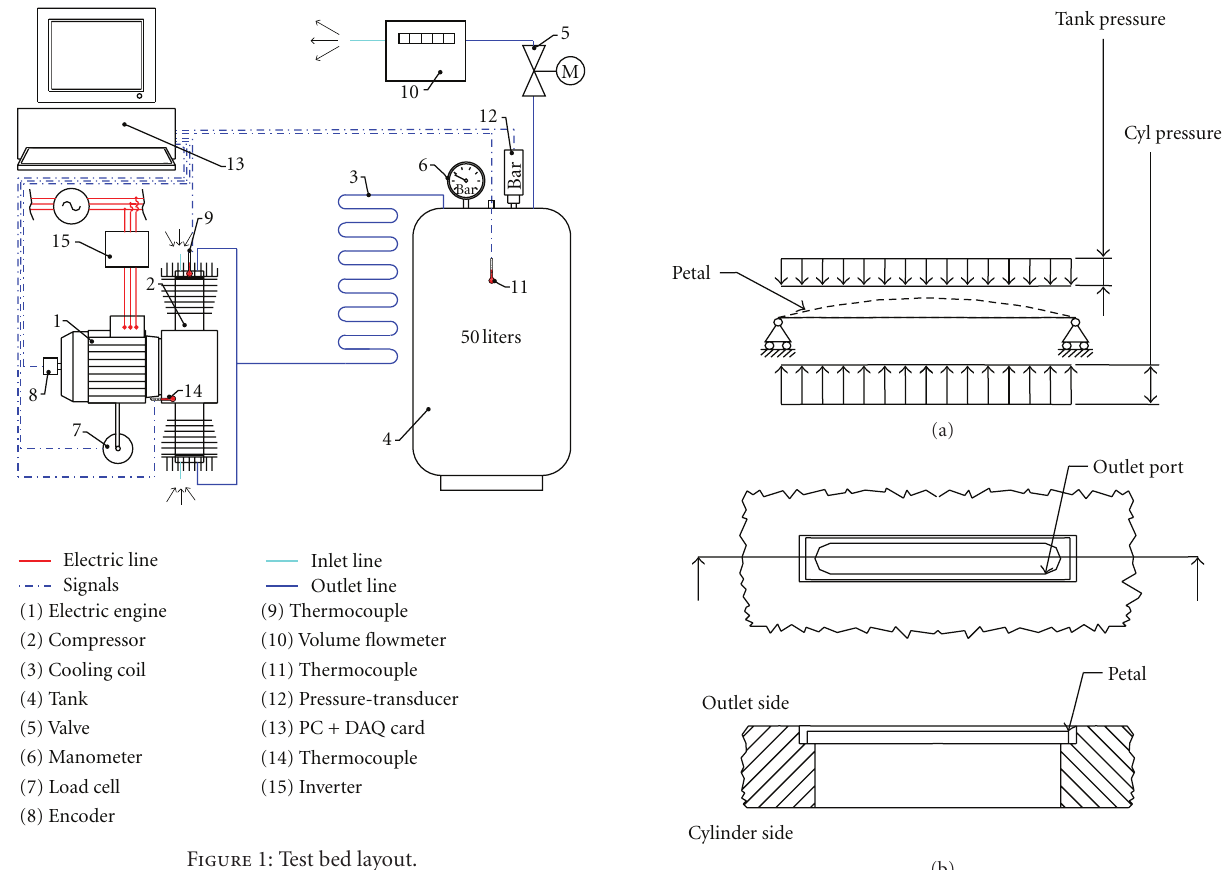
Figure 1: Test bed layout.